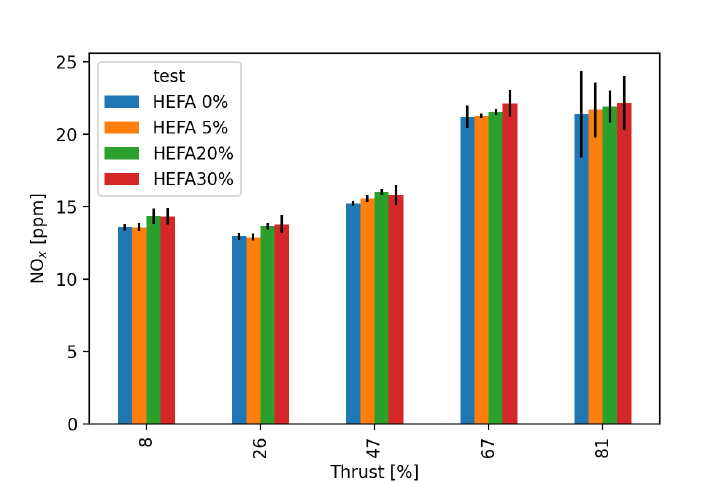
Figure 21. GTM-140/HEFA: NO x .